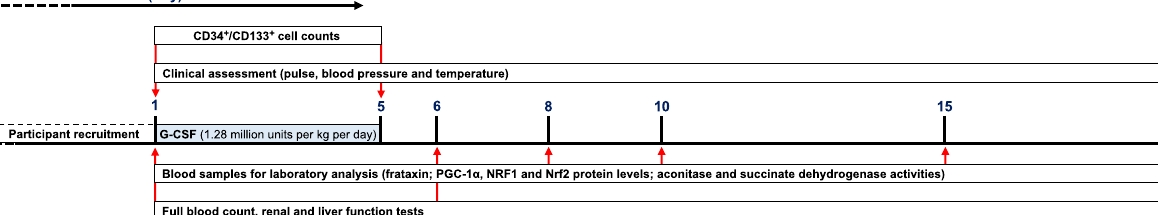
Fig. 1 Trial timeline. Red arrows indicate the day of